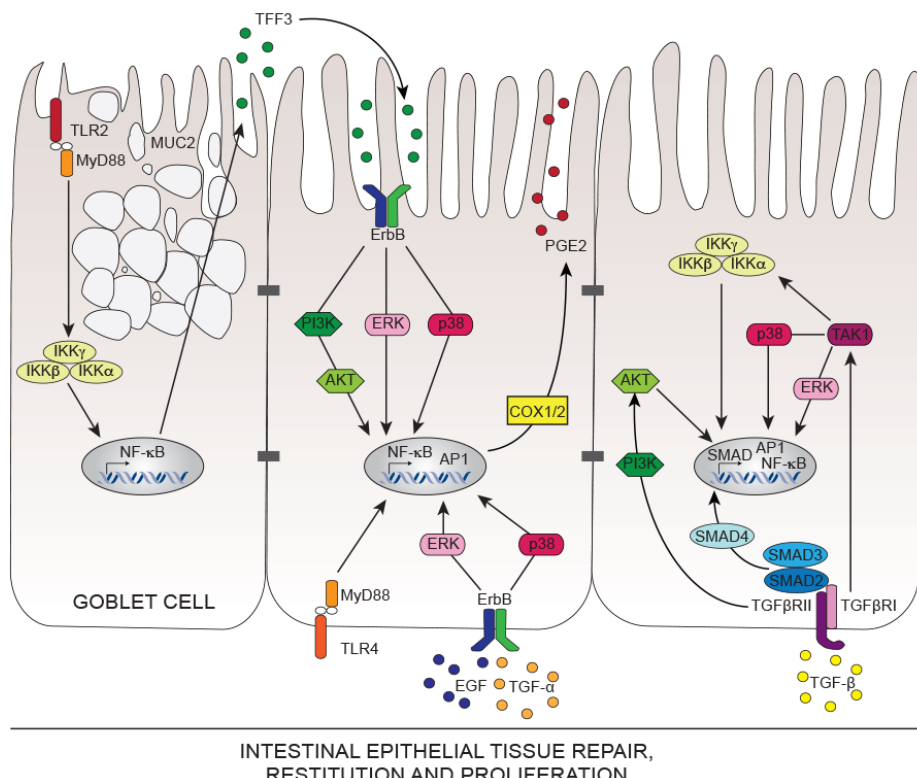
Figure 1. Signal transduction pathways involved in intestinal epithelial tissue repair.